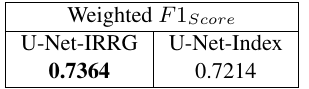
Table 3. Weighted F 1 Score for baseline results over